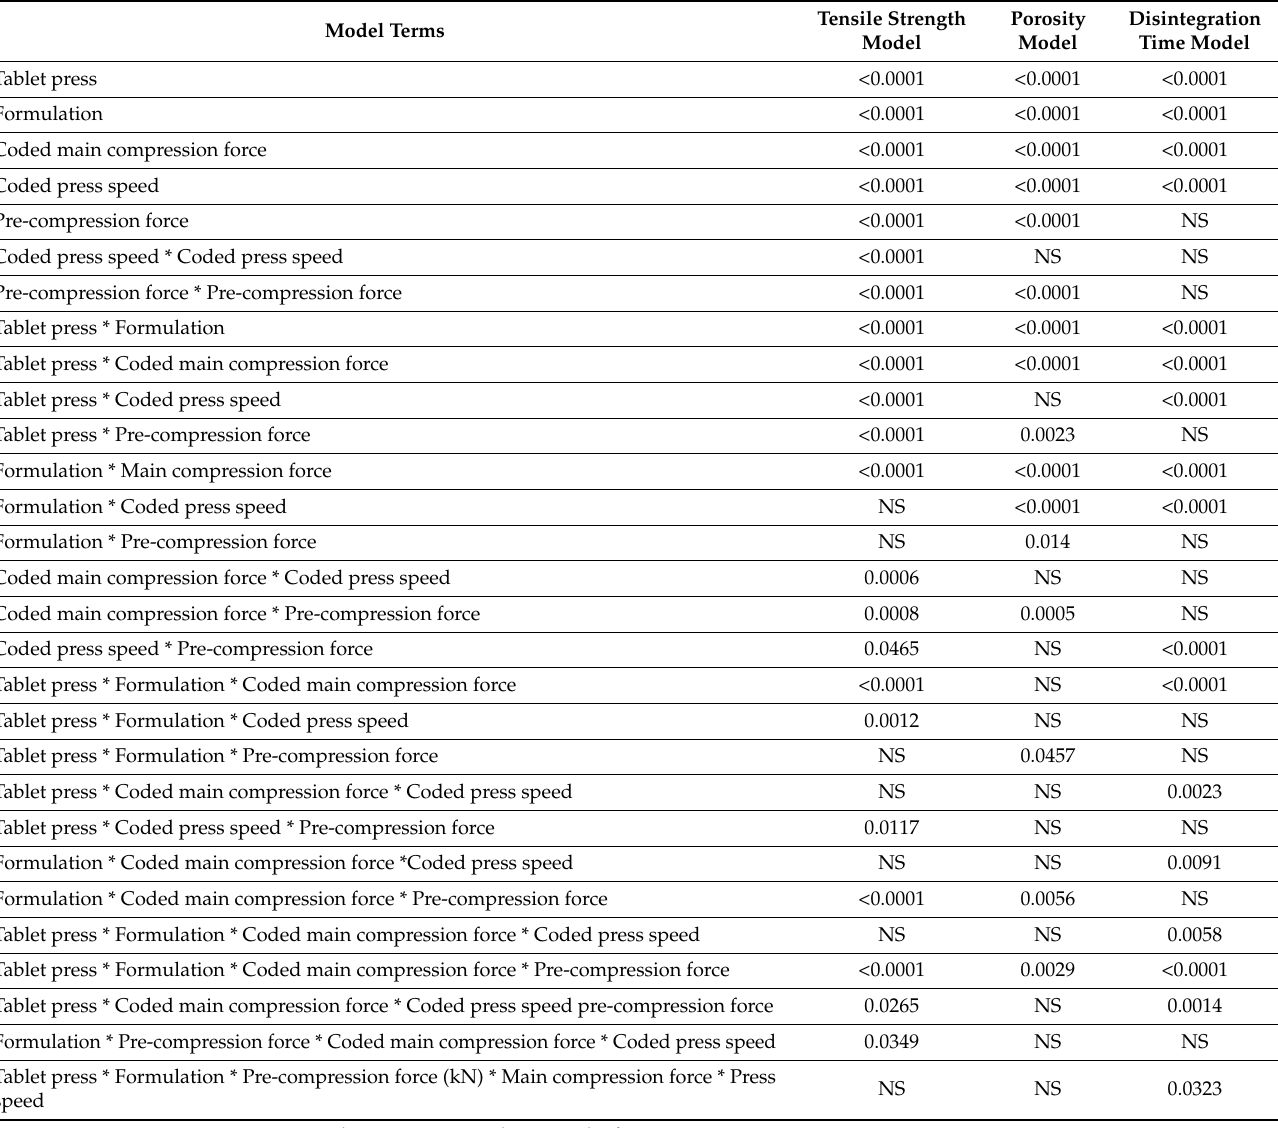
Table 4. Effect summary of model terms (factors) and their interactions showing significant effects ( p < 0.05) on the log-transformed tensile strength, porosity and square-root-transformed disintegra- tion time. NS indicates not significant ( p >